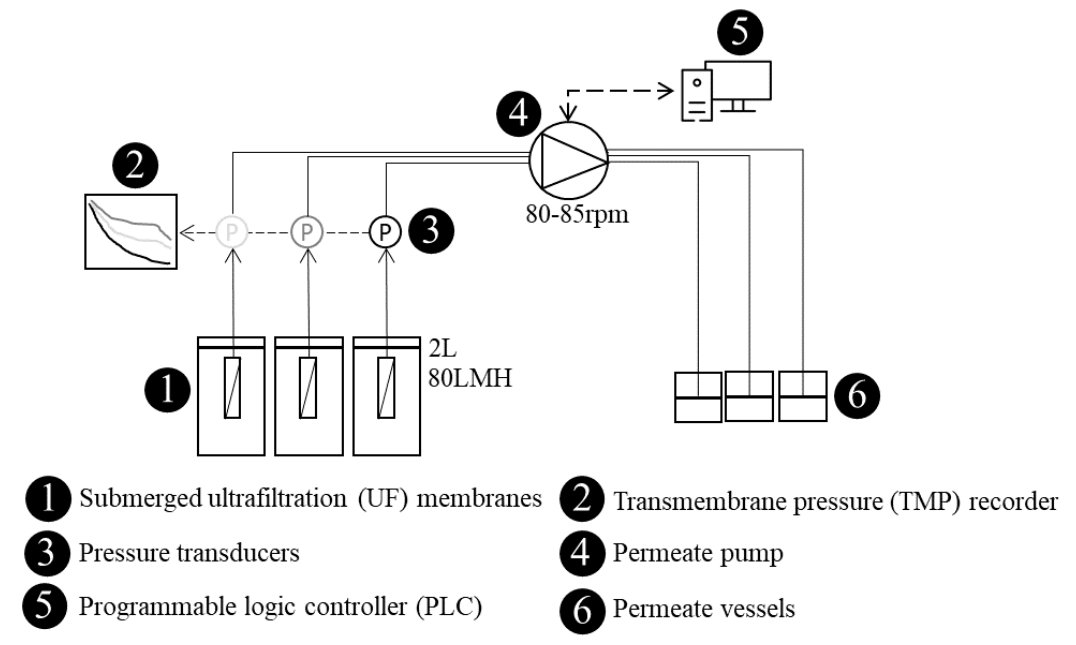
Figure 2. Membrane filtration bench scale setup .